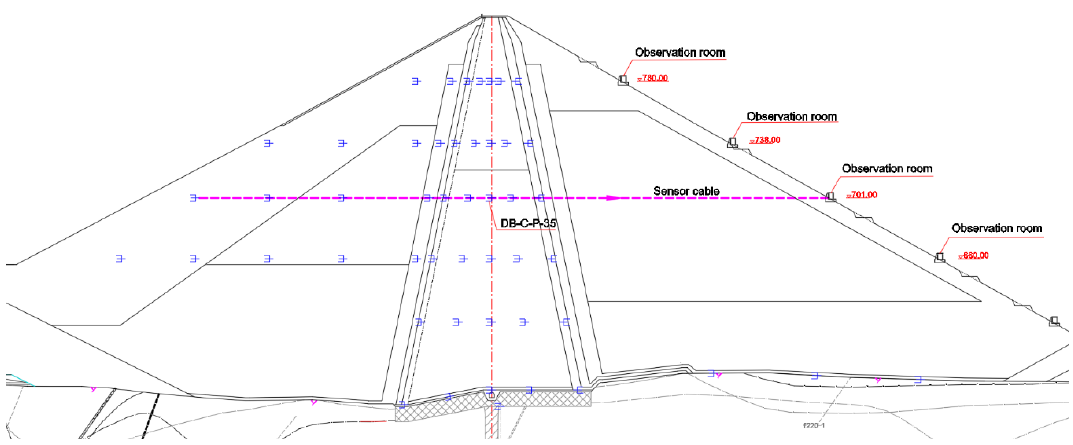
Figure 4. Schematic diagram of burial of typical osmometer (DB-C-P-35) and cable traction.